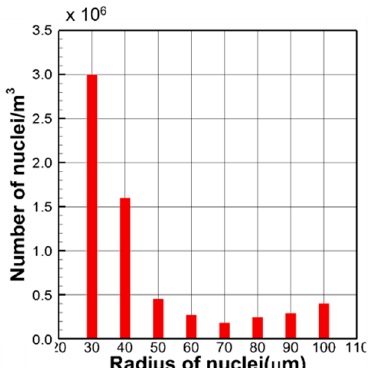
Figure 5. Number of nuclei per unit volume as a function of the particle radius in the ocean.